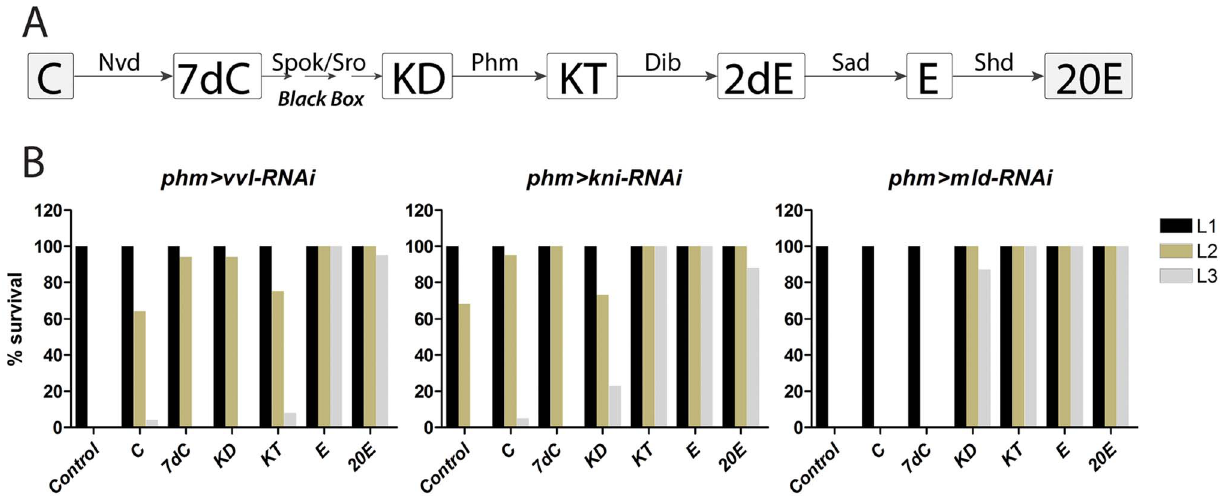
Figure 5. Ecdysone and 20E efficiently rescue loss of vvl and kni in the PG. (A) Ecdysone biosynthetic scheme showing steps in the conversion of cholesterol to 20-hydroxyecdysone (20E). Note that ecdysone produced and released from the PG is converted to its active form 20E in peripheral tissues. (B) Percentage of larvae developing to the indicated stage. L1; first instar larvae, L2; second instar larvae, L3; third instar larvae. Resupplying precursors later in the pathway is gradually more efficient in rescuing arrest of larvae with reduced expression of vvl and kni in the PG. In contrast, only precursors downstream of the black box efficiently rescue mld-RNAi larvae, indicating that Mld regulates a gene product(s) involved in the reactions upstream of the 5 b -ketodiol. C; cholesterol, 7dC; 7-dehydrocholesterol, KD; 5 b -ketodiol, KT; 5 b -ketotriol, 2dE; 2-deoxyecdysone, E; ecdysone, 20E; 20-hydroxyecdysone.